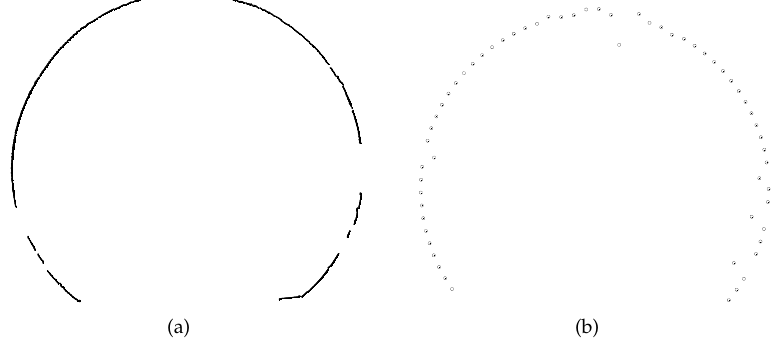
Figure 14. Identified cross-sectional profile of metro tunnel: ( a ) By the proposed method and ( b ) by the total station.